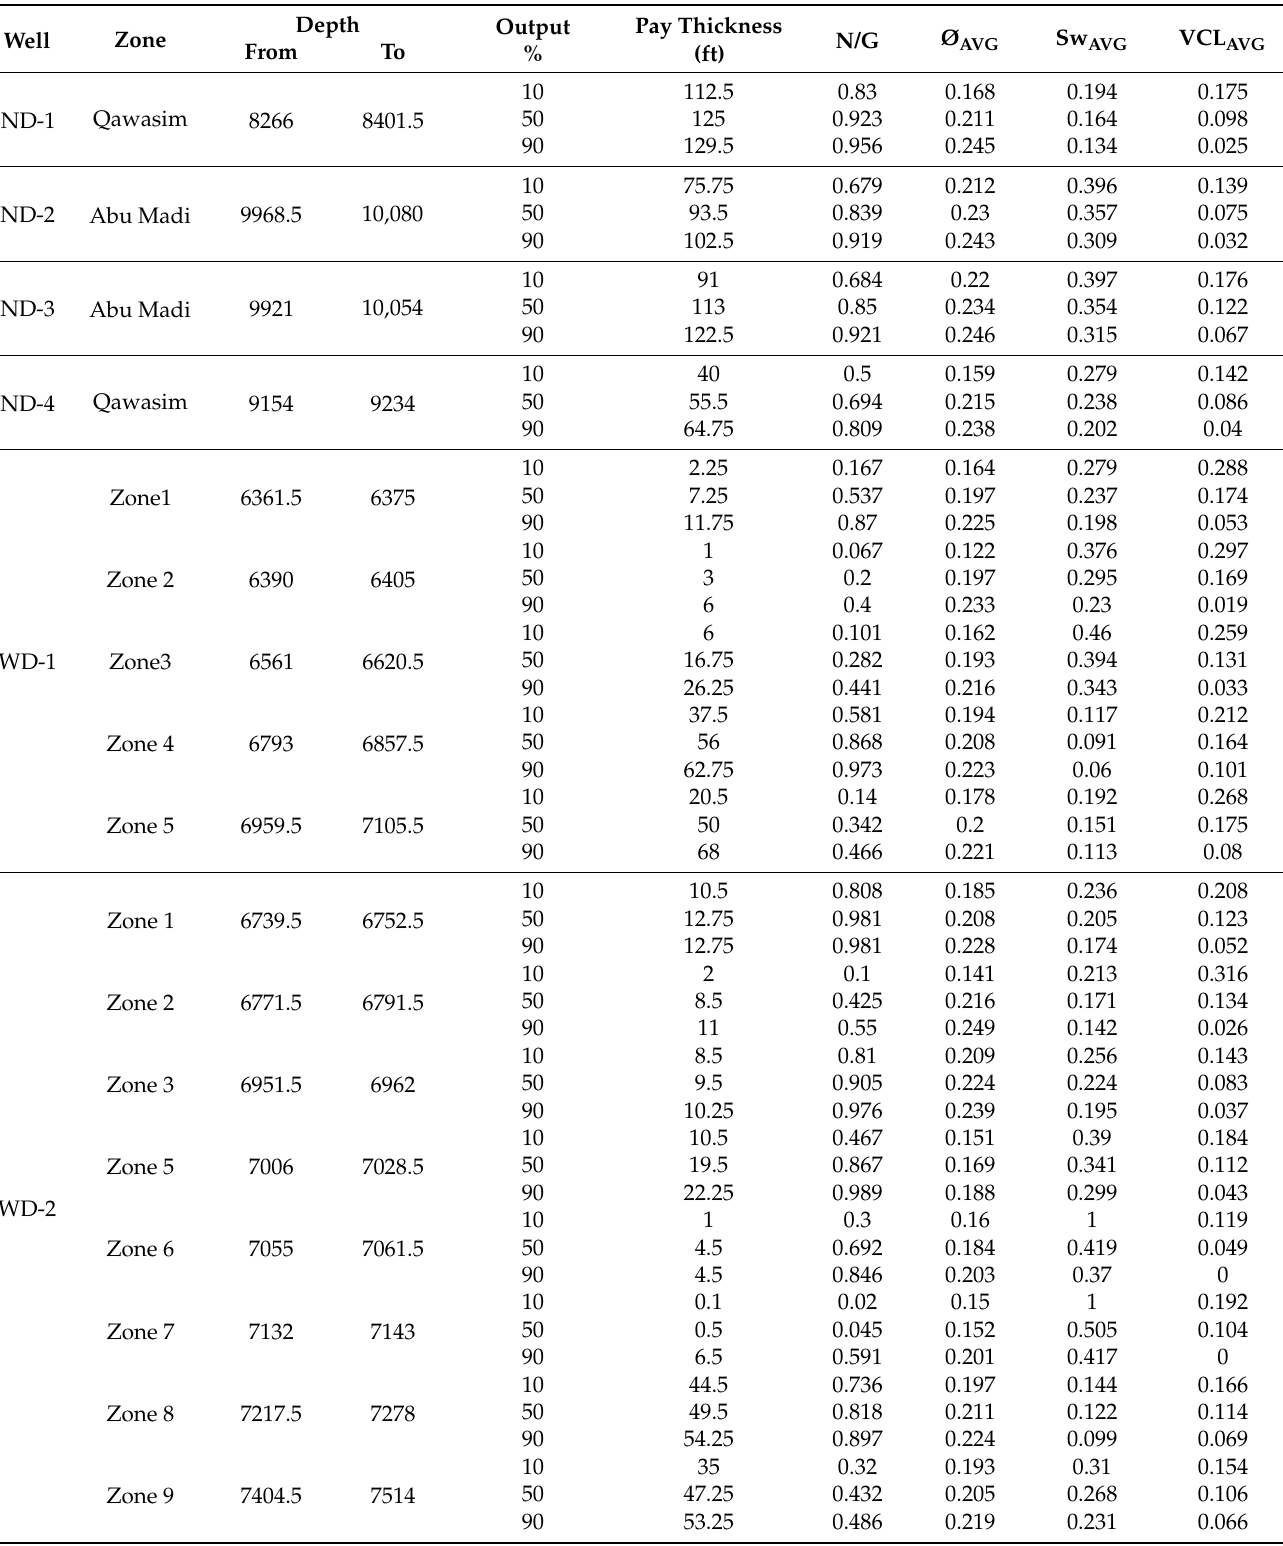
Table 4. The reservoir parameters derived from Monte Carlo simulation for all well zones at different